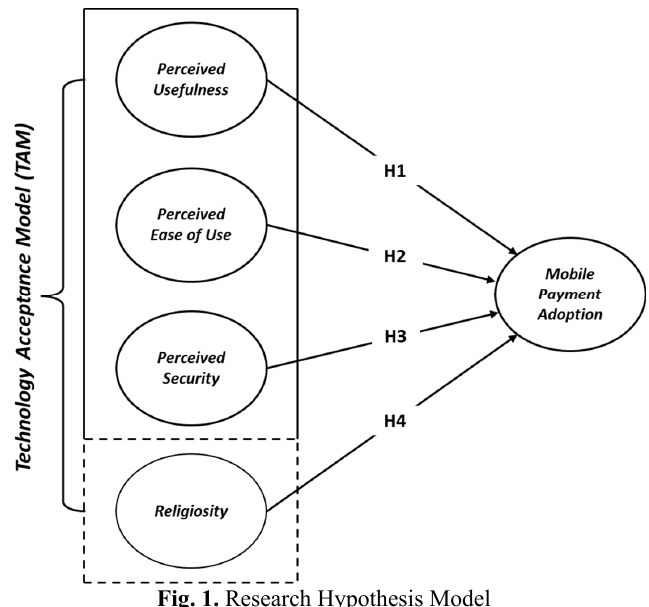
Fig. 1. Research Hypothesis